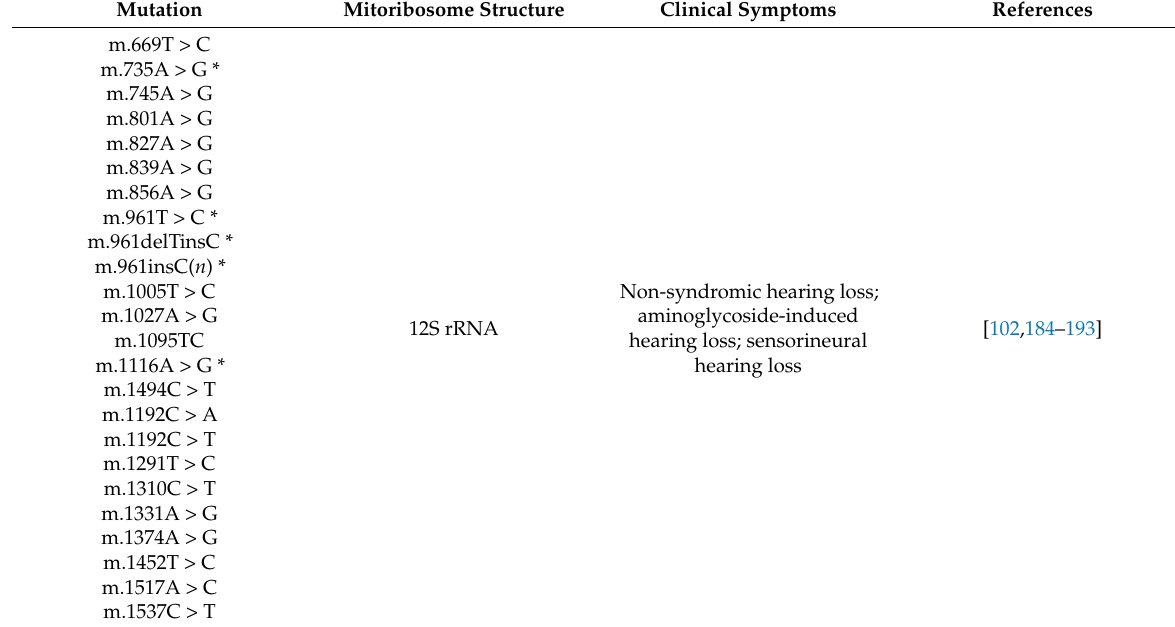
Table 1. Mutations in mitoribosome structural components and assembly factors associated with human disease. The listed mutations are mapped on the mitoribosome structure (Figure 4), except those labeled with an asterisk (*), since the corresponding residues are not resolved in the structures used in the